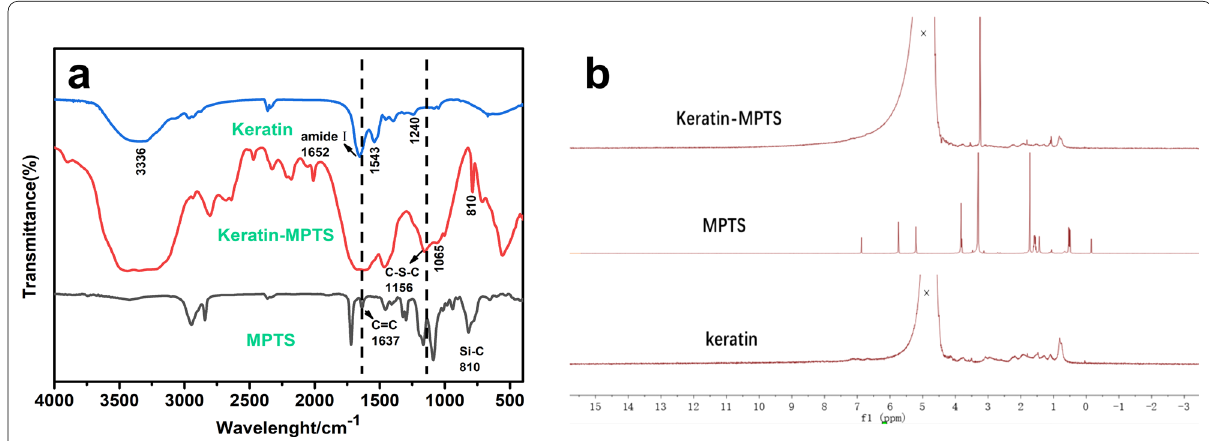
Fig. 2 a FTIR and b 1 H-NMR spectra of MPTS, keratin and